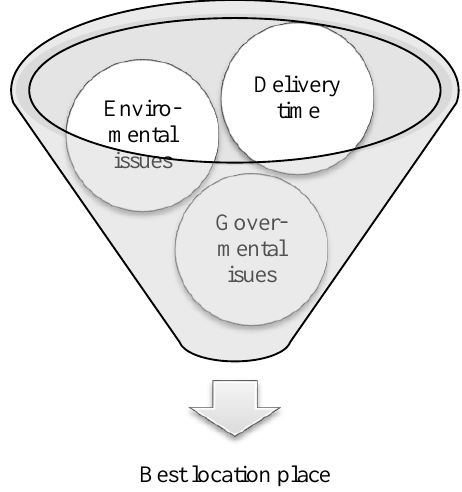
Fig. 3. The most important impact on deciding of place selection (made by the